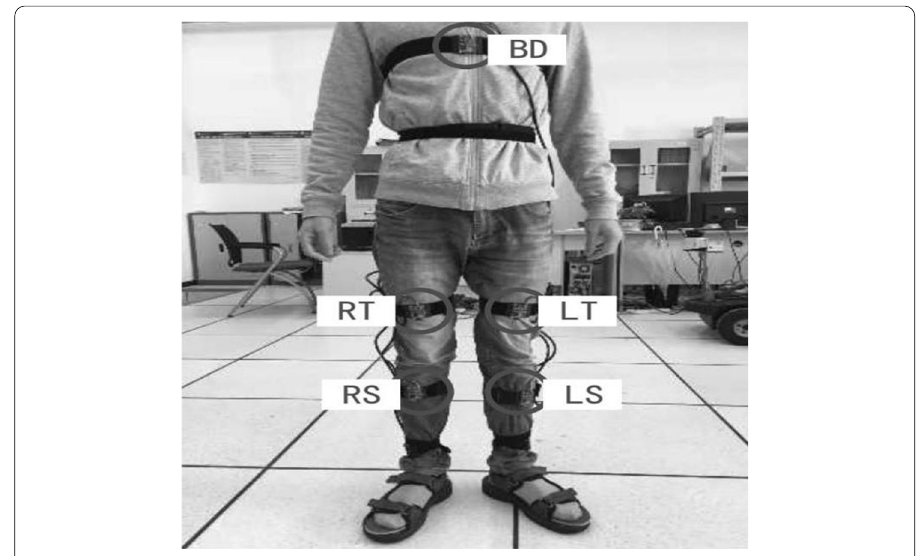
Fig. 7 Accelerometer layout